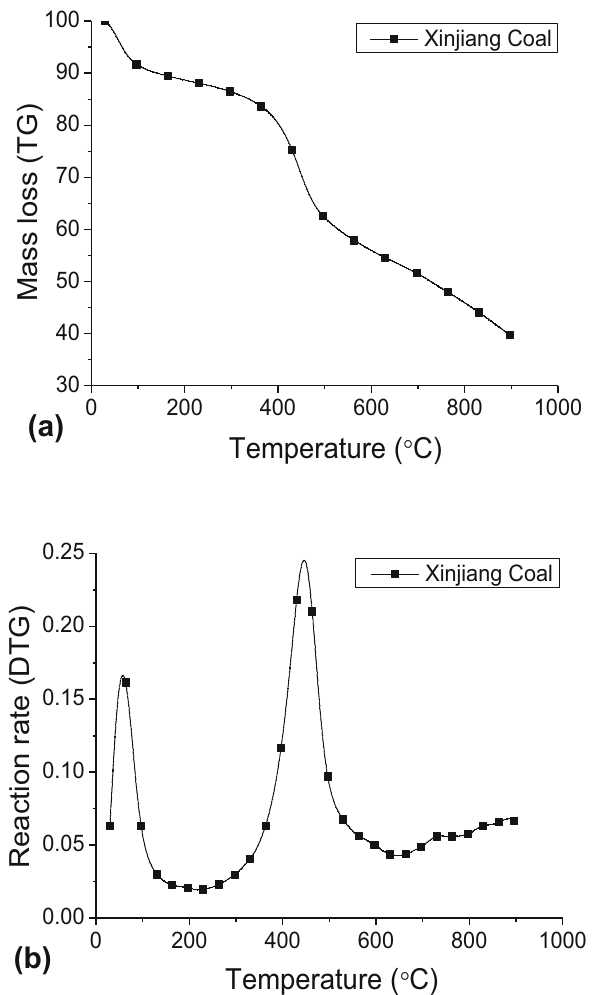
Fig. 5 Pyrolysis behavior in thermogravimetric analyzer